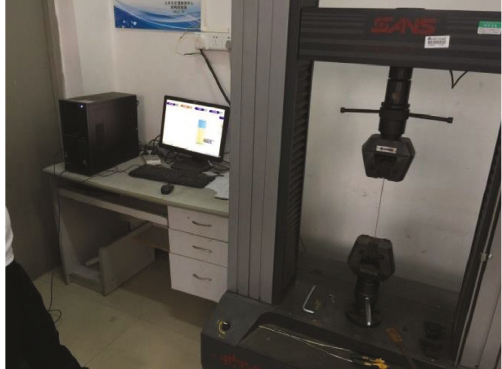
Figure 5: Tensile test for the galvanized steel